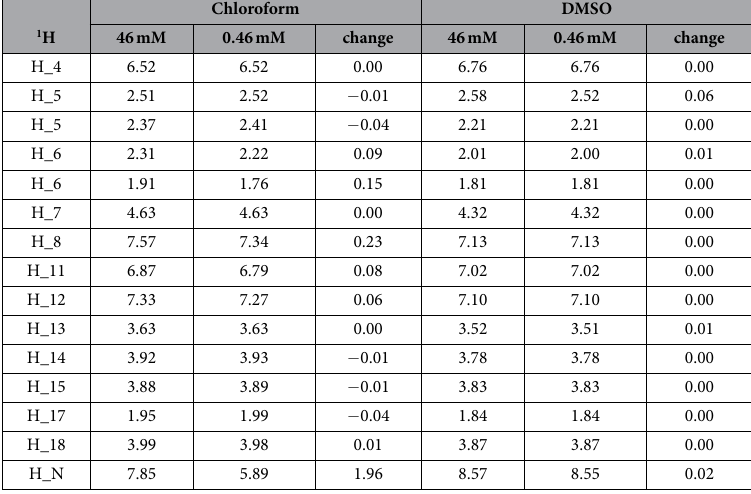
Table 3. Comparison of 1 H chemical shifts of colchicine in chloroform and DMSO at concentrations of 46 mM and 0.46 mM.